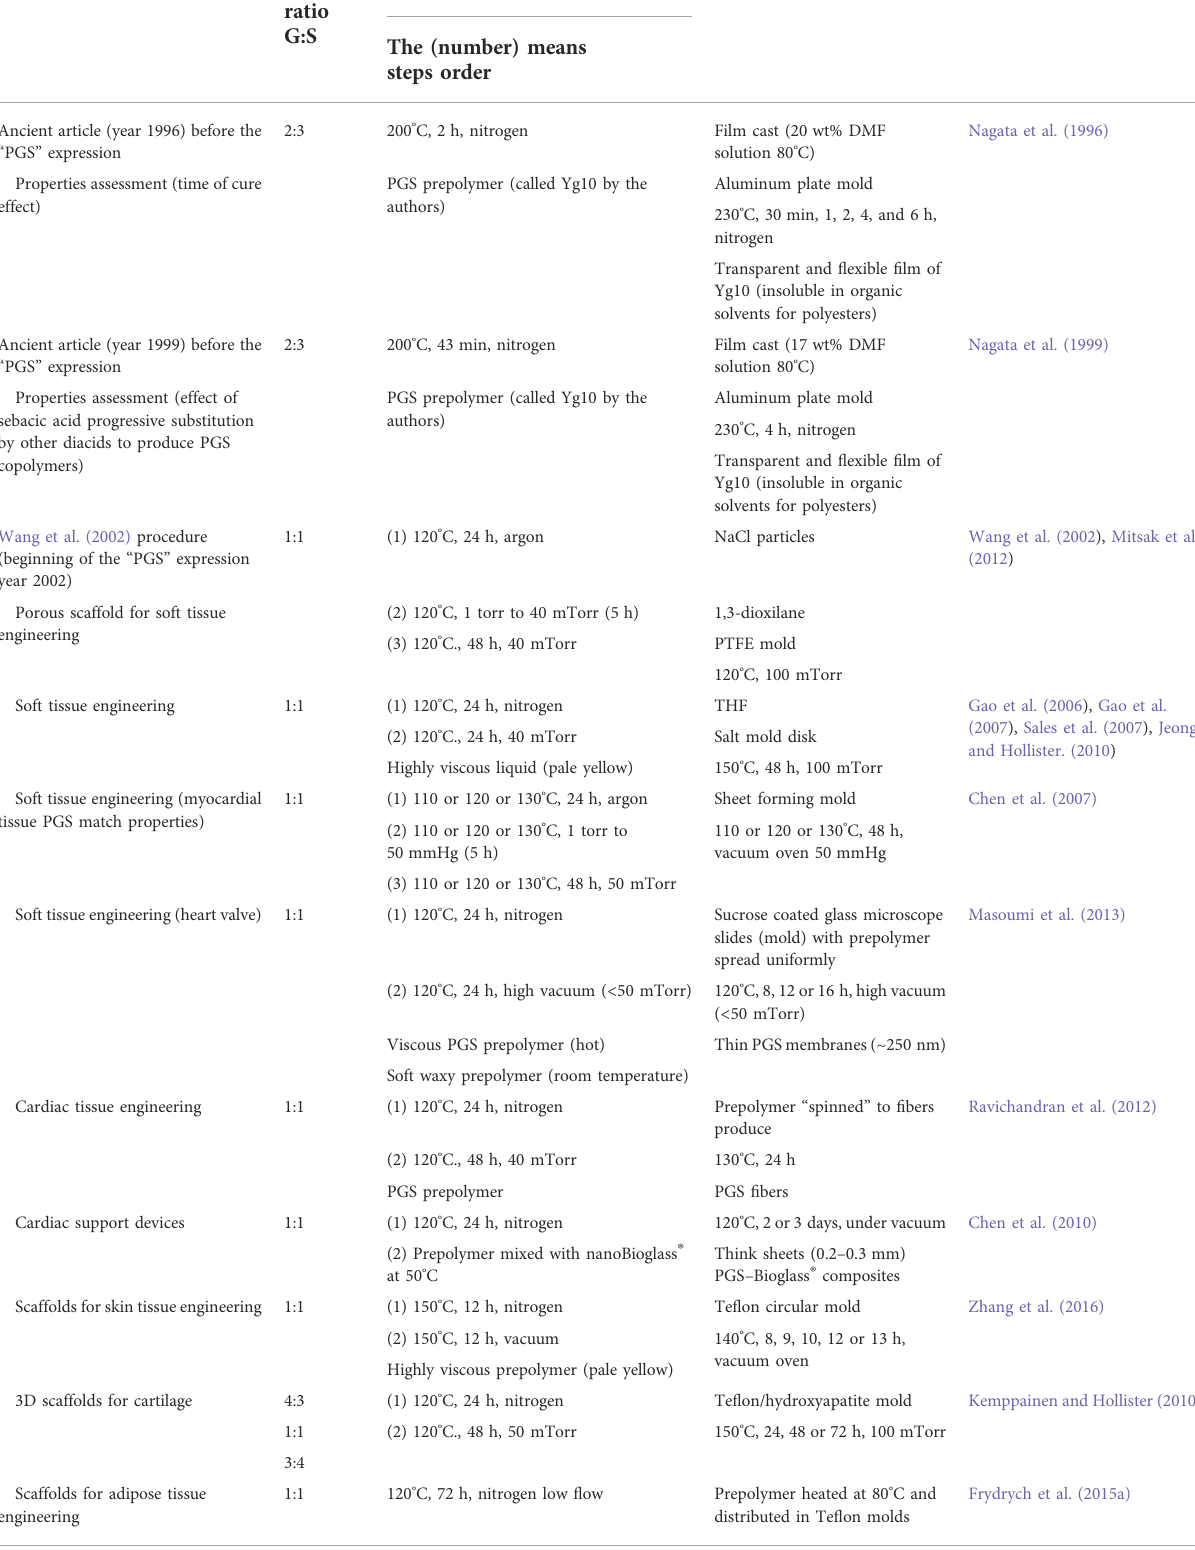
TABLE 1 Synthesis conditions for PGS and PGS-based